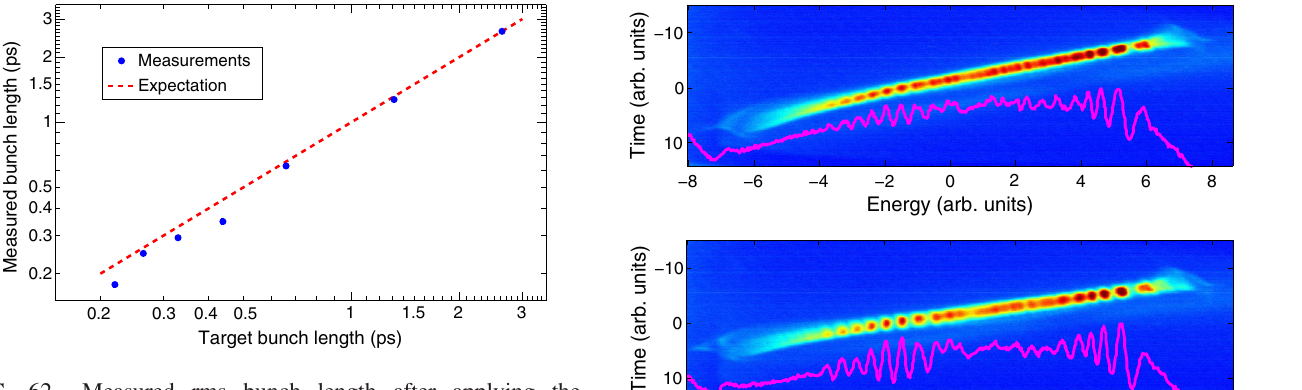
FIG. 62. Measured rms bunch length after applying the compression procedure, compared to the respective target bunch length. (Statistical errors, obtained from repeated measurements, are smaller than the marker circles.)